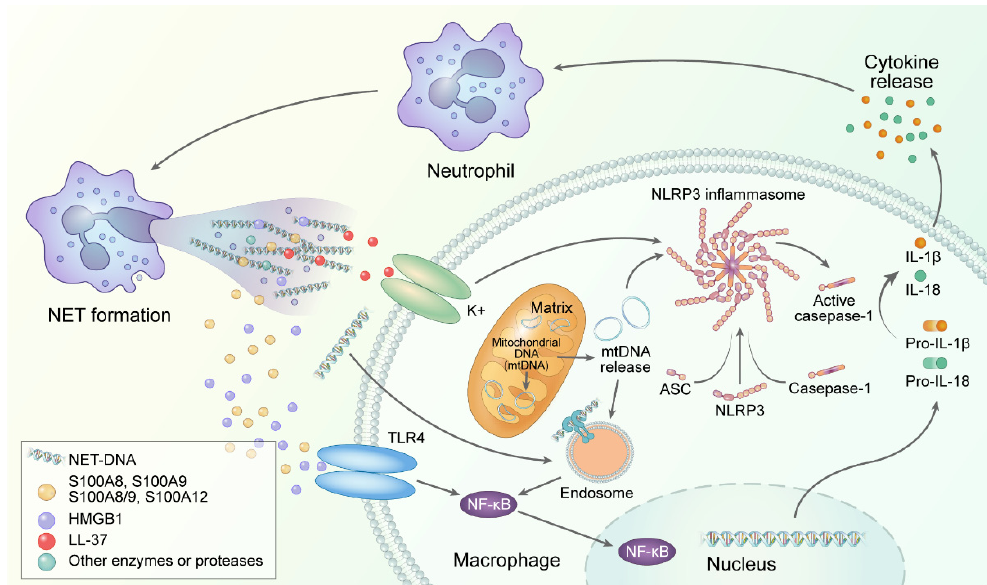
Figure 2. Neutrophil extracellular traps and its implications in AOSD and SJIA. Several neutrophil extracellular traps (NETs) released through neutrophils such as S100 protein, high mobility group box-1 protein, and LL–37 accelerate inflammation with a proinflammatory cascade through toll–like receptor 4 or receptor for advanced glycation end products or inflammasome activation. NET formation promotes cytokine storms by linking neutrophils and macrophages.